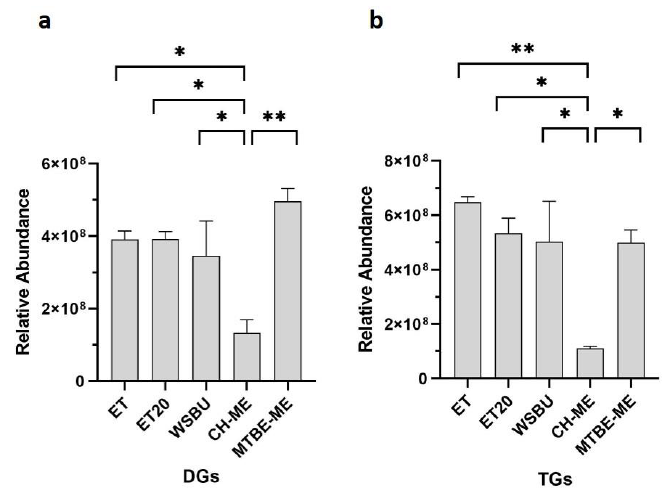
Figure 7. Relative abundance of glycerides in terms of DGs ( a ) and TGs ( b ) in different extraction methods (mean ± SD of two replicates, * = p -value < 0.05, ** = p -value < 0.01).